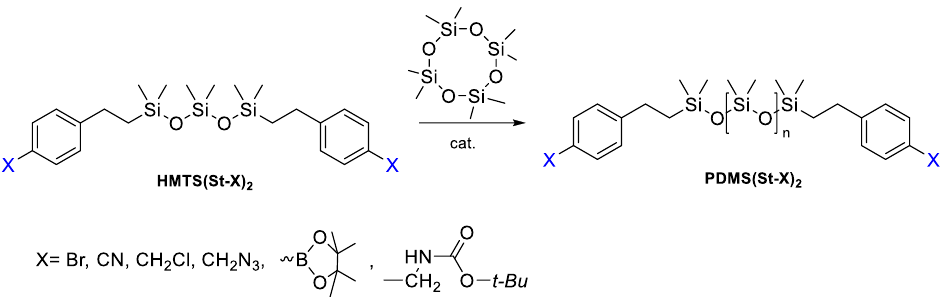
Figure 17. Common scheme of the polymerization of octamethylcyclotetrasiloxane with functional trisiloxanes as stoppers.